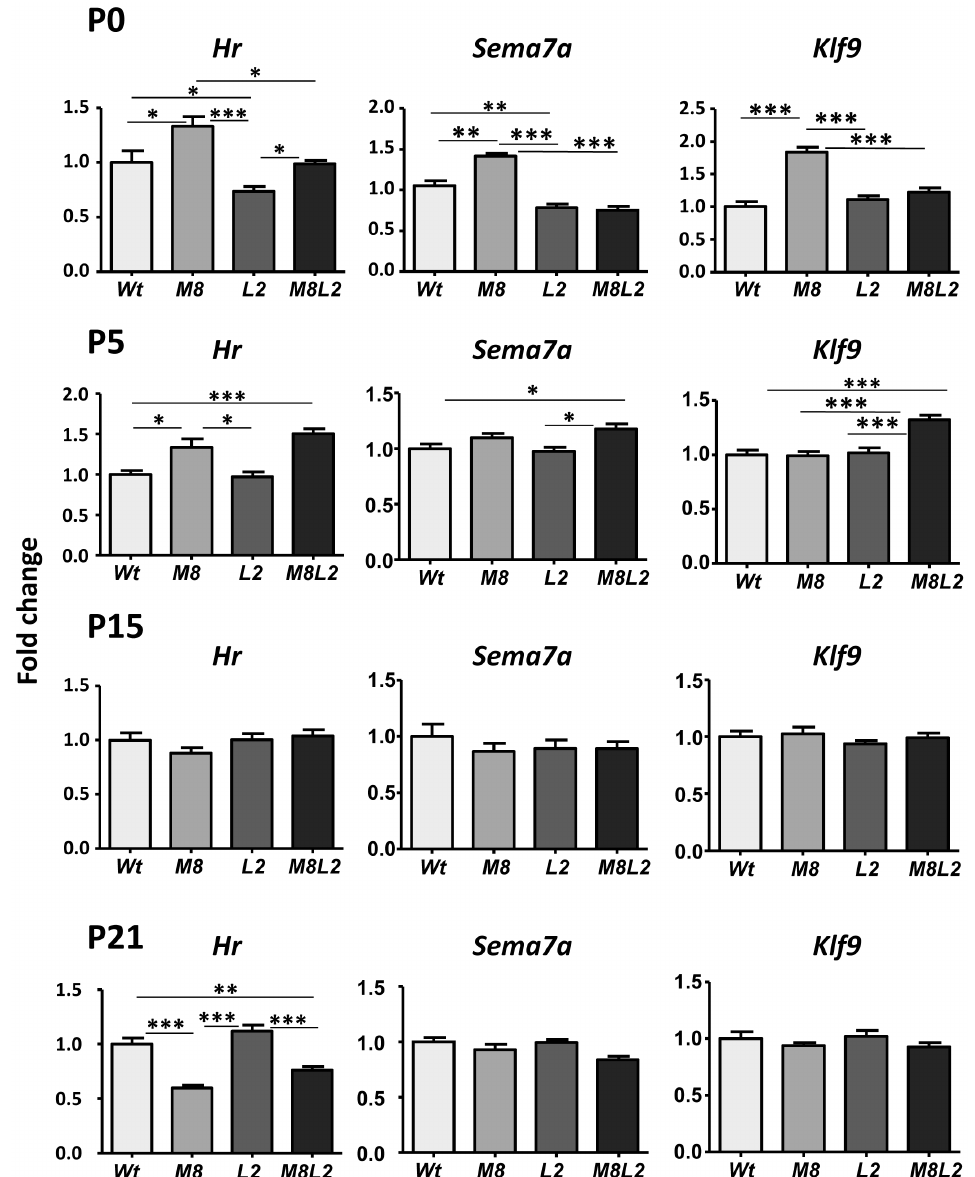
Figure 3. Gene expression (mean ± SE) in the cerebral cortex and liver of mice of different genotypes and ages as indicated. Wt = wild type mice; M8 = Mct8KO ; L2= Lat2KO ; M8L2= Mct8Lat2KO . Measurements were by qPCR, and the data expressed relative to 18S RNA. Significance of differences was calculated by one way ANOVA and the Tukey posthoc test. Only relevant significant comparisons are indicated. * P , 0.05. ** P , 0.01. *** P , 0.001. Hr : Hairless mRNA. Sema7a : Semaphorin 7a mRNA. Klf9 : Kruppel factor 9, or BTEB mRNA. P0, P5, P15, P21: postnatal days 0, 5, 15, or 21.